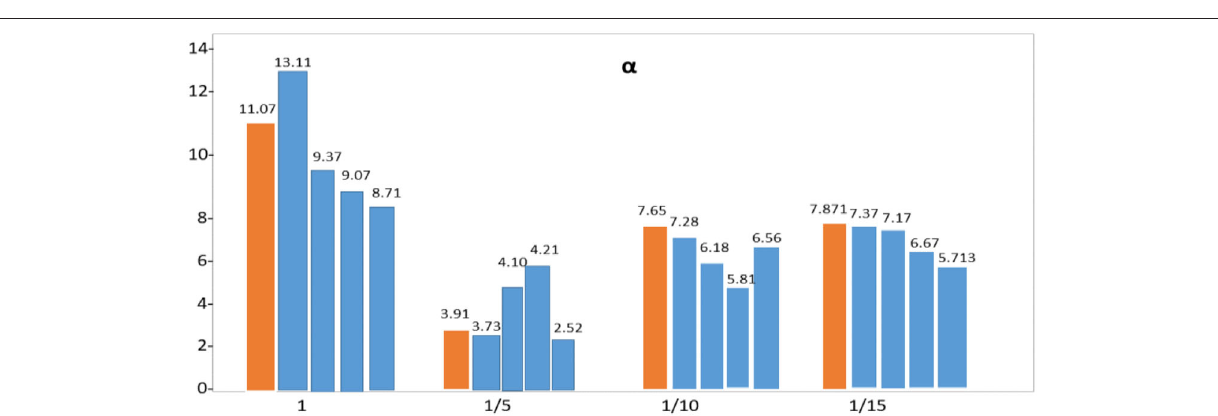
represents the actual reported,